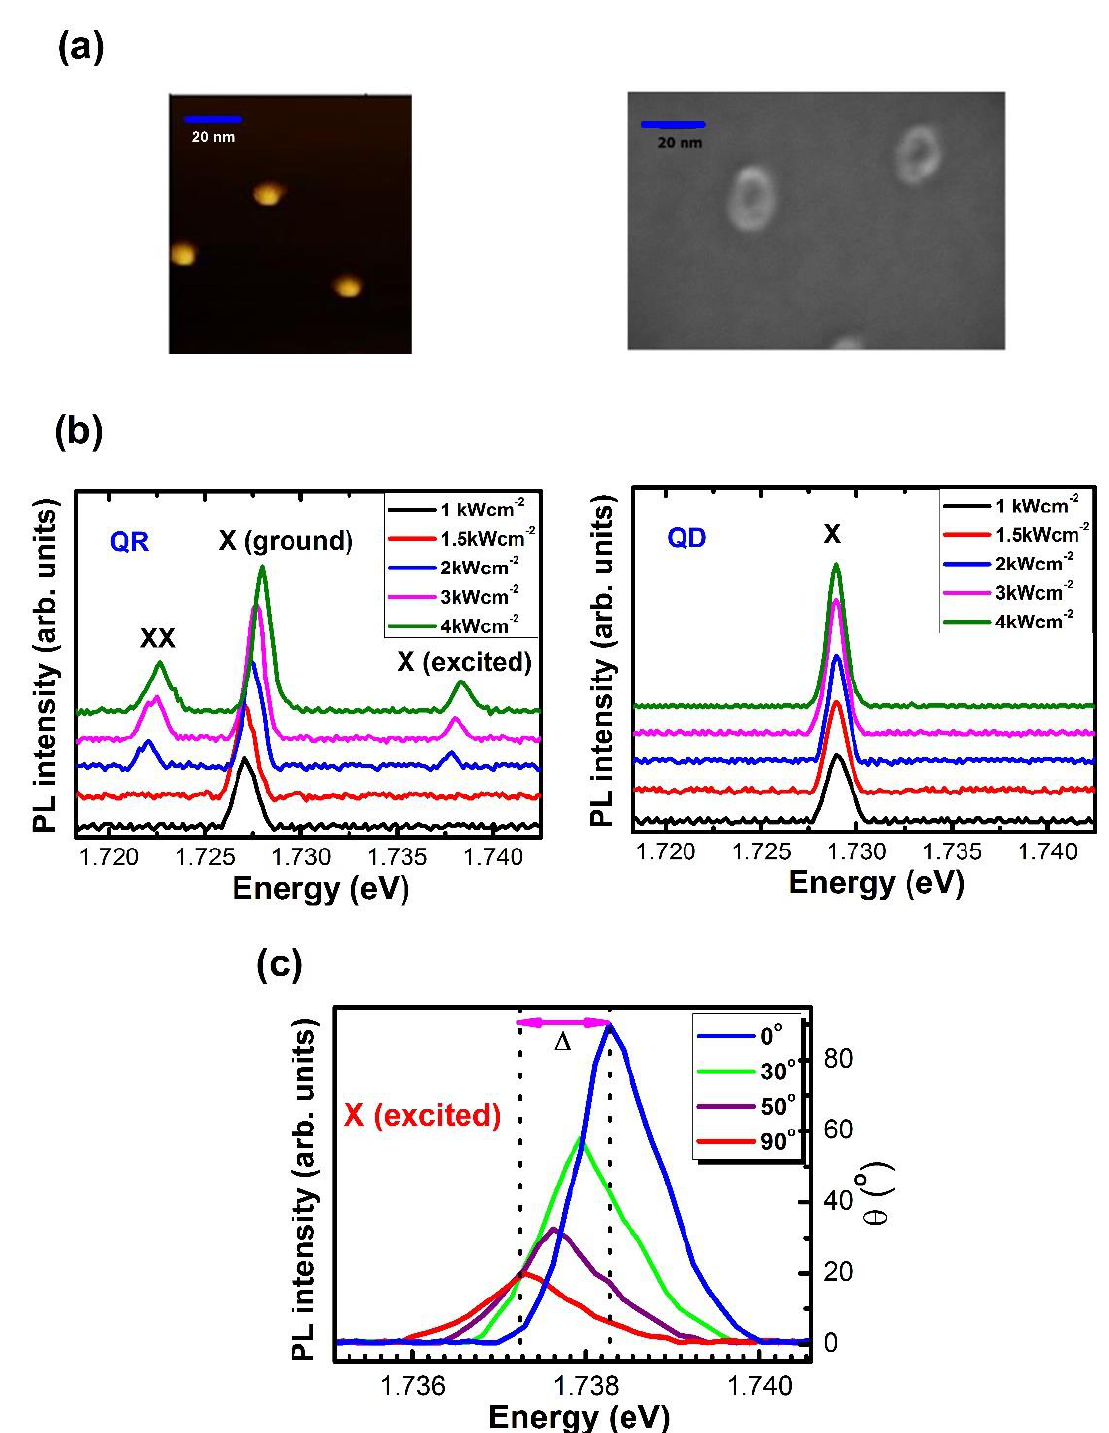
Figure 1. ( a ) Single QD/QR structure observed via SEM. ( b ) Excited X ( N = 2) and XX (biexciton) states appear from a single GaAs QR with increasing excitation power. The ground- and excited-state exciton (X) is blue-shifted because of the sequential filling of fine-structure states. Only ground state exciton states are observed from a single QD with no peak shifts. ( c ) PL spectra of X ( N = 2) at different analyzer angles, exhibiting strong polarization dependence between the analyzer angles of 0° and 90° with energy splittings ( Δ ).